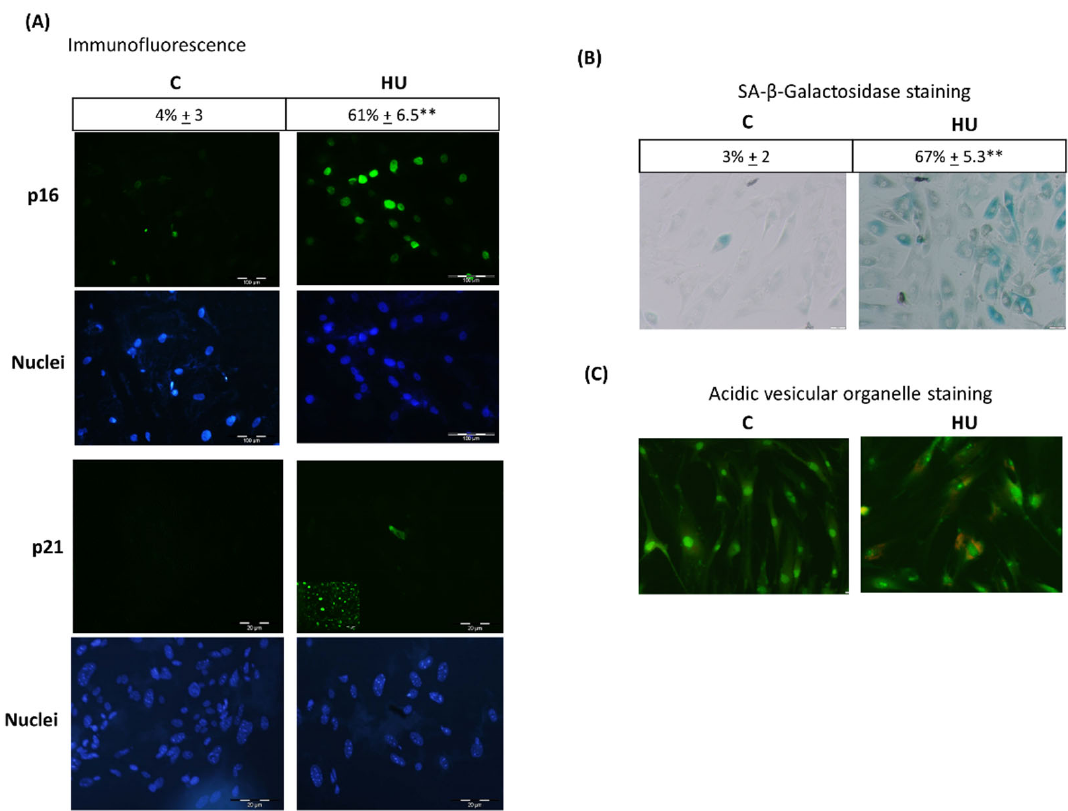
Figure 3. Hydroxyurea induces BMMSC senescence. BMMSC were treated for three days with 200 µ M of HU ( A ) fixed and immunostained for p16INK4, magnification 160 × , Bars = 100 µ m, or p21Cip1, magnification 240 × , Bars = 20 µ m. Corresponding nuclei were stained with DAPI. P21 Cip1 insert, positive control of BMMSC treated with 100 nM of doxorubicin. ( B ) Subjected to histochemistry analysis for SA- β -gal observed as blue-green cell staining. Magnification 80 × , Bars= 10 µ m. ( C ) subjected for acidic vesicular organelles (AVOs) staining with acridine orange. Magnification 80 × , Bars = 10 µ m. Results presented are representative from at least 3 performed experiments. Significant difference control cells by t -test, p < 0.005 (**).